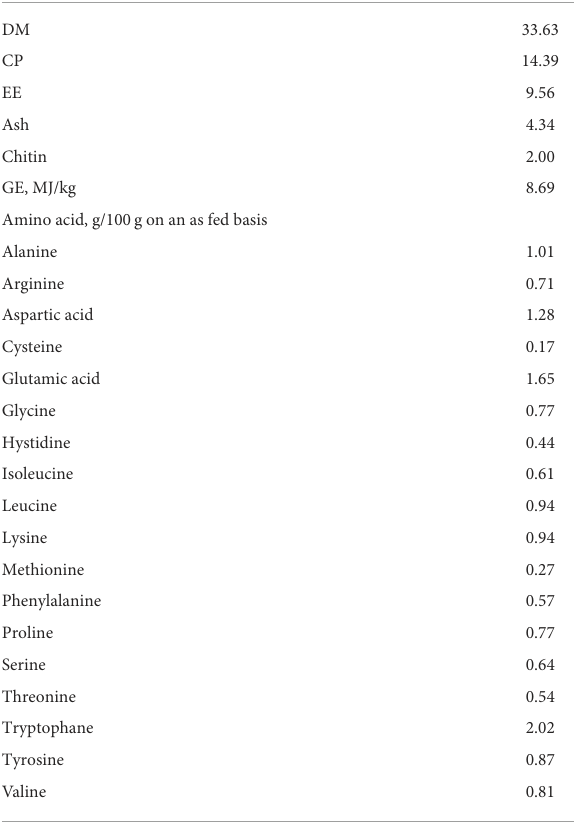
TABLE 2 The analyzed proximate and amino acid composition of black soldier fly larvae. Proximate composition, g/100g on an as fed